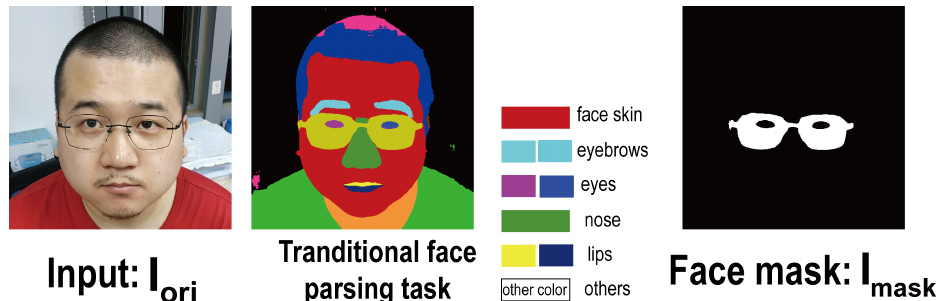
Figure 2. Our face mask generation module. It is slightly different from the traditional face parsing task. The traditional face parsing task is to recognize the face as different components (usually including eyebrows, eyes, nose, mouth, facial skin and so on). Corresponding to it is the face parsing map (different face components are represented by different gray values). Our mask generation task is only to recognize the occluded area. The corresponding face mask map is a binary